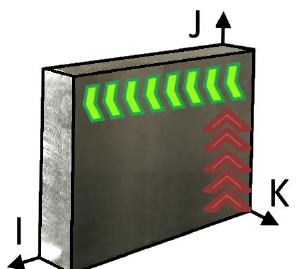
Figure 4. Schematic overview of the two machining directions in the IJ-plane of the workpiece. The green arrows show the machining parallel to the I-direction, and the red arrows show the machining parallel to the J-direction.